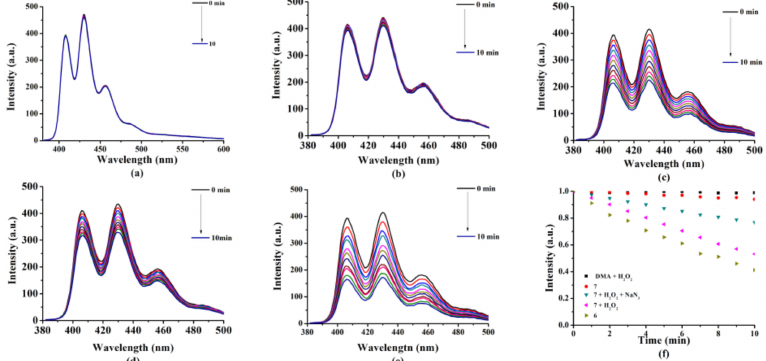
Figure 8. The fluorescence emission spectra of DMA (6 µ M) after different durations of 670 nm laser irradiation ( a ) only DMA in the presence of H 2 O 2 ; ( b ) with compound 7 (5 µ M); ( c ) with compound 7 (5 µ M) in the presence of H 2 O 2 (250 µ M); ( d ) with compound 7 (5 µ M) in the presence of H 2 O 2 (250 µ M) and NaN 3 ; ( e ) with compound 6 (5 µ M) in the absence of H 2 O 2 .; ( f ) comparison of the degradation rates of DMA as monitored by the decrease in fluorescence intensity at 432 nm (excited at 370 nm) with irradiation time; the experiments are carried out in phosphate buffer solution (10 mM, pH 7.4) containing 0.05% Tween